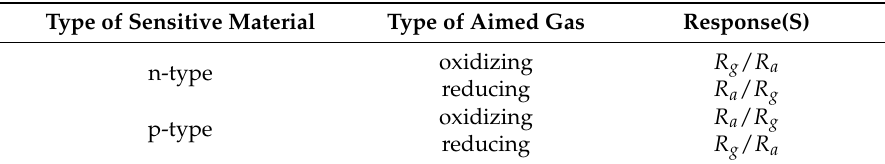
Table 1. Response of gas sensors in different conditions.